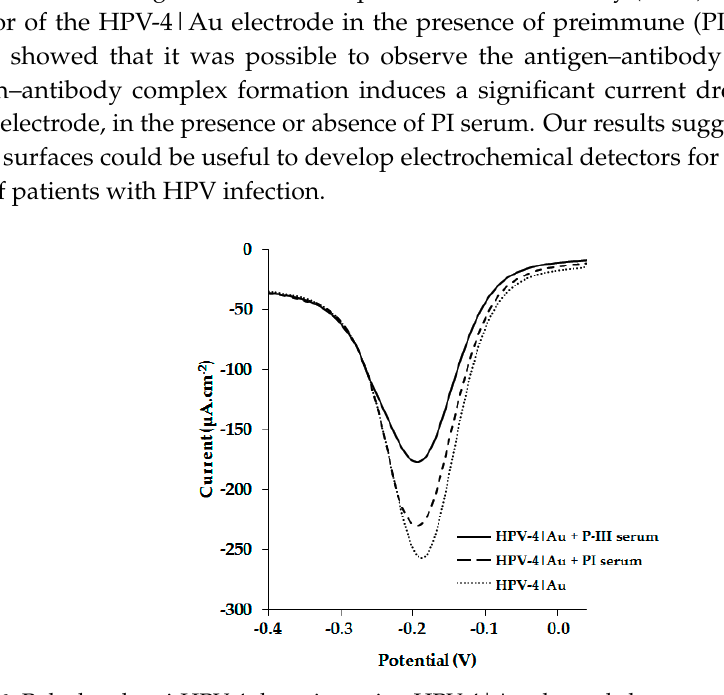
Table 2. Thermodynamic parameters for the process Ru(NH (cid:2871) ) (cid:2874)(cid:2871)(cid:2878)/(cid:2870)(cid:2878) using for the current measuring bare Au, HPV-4|Au and HPV-5|Au electrodes.